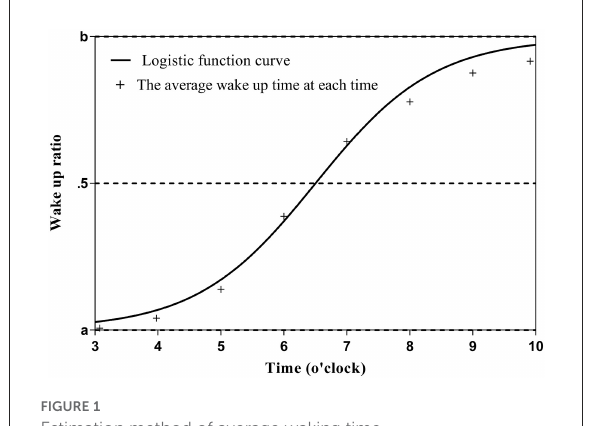
FIGURE1 Estimation method of average waking time.